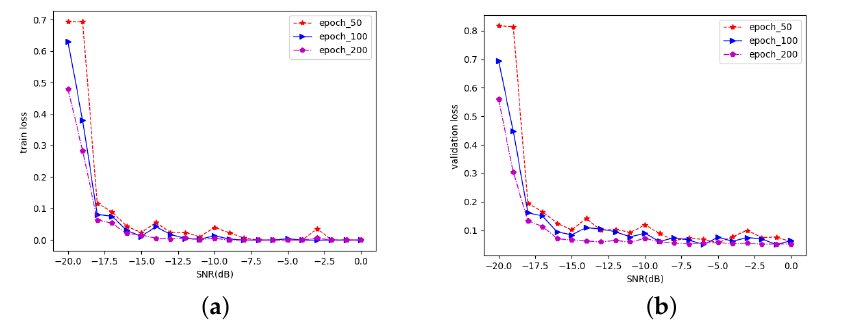
Figure 6. Change of AlexNet model loss value under different epochs. ( a ) Training loss; ( b ) validation loss.